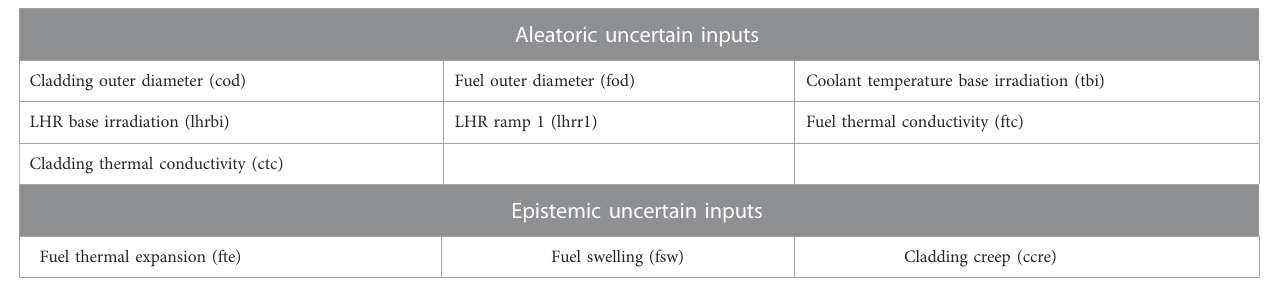
TABLE 3 Reduced uncertain inputs subset.